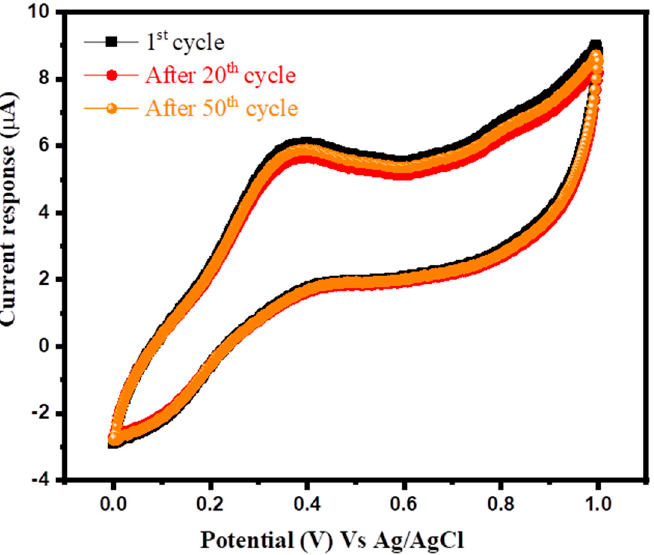
Figure 7. CV responses (1st, 20th, and 50th) of NiO-GE for 5 ppb As 3+ (0.1 M PBS of pH = 6) at scan rate = 50 mVs − 1 .